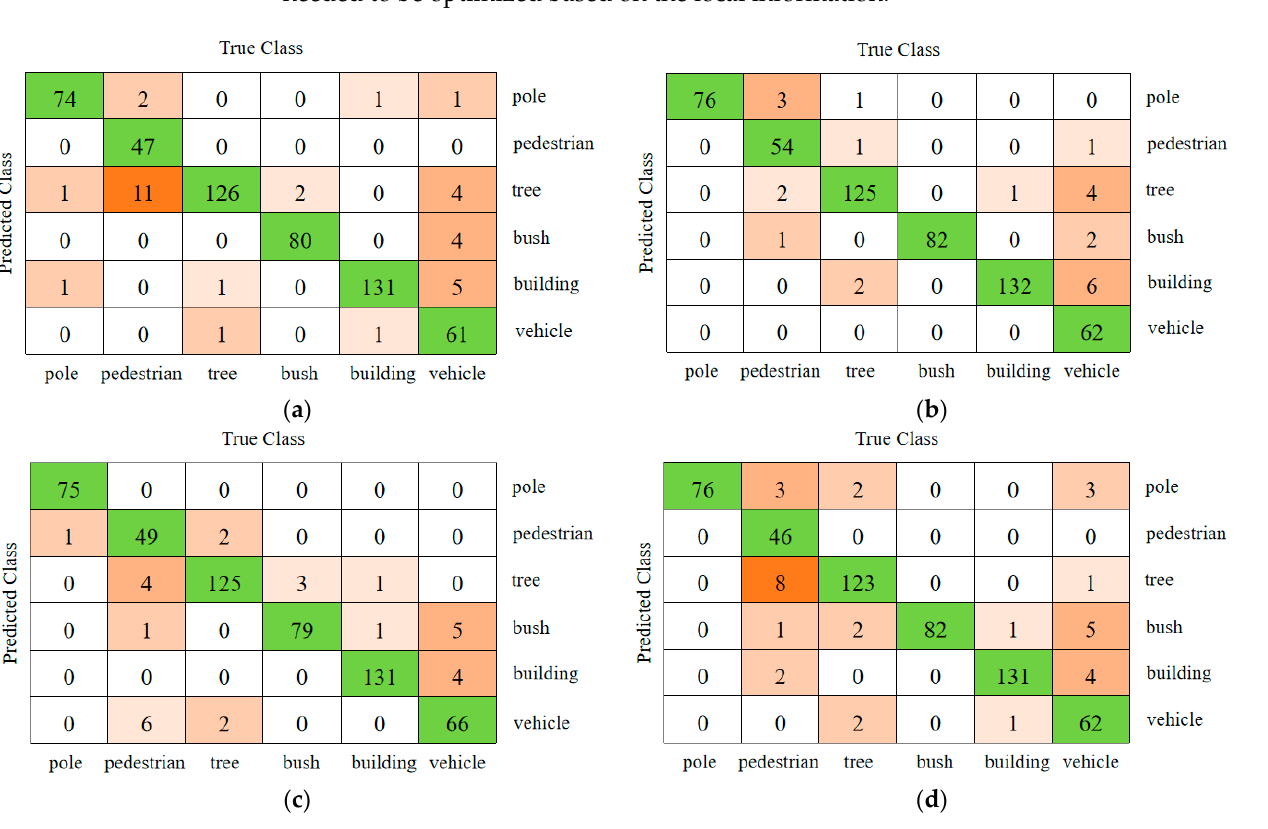
Figure 10. Classification confusion matrix for 6 kinds of object point clouds with different resolu ‐ tions: ( a ) 20 × 20 × 20, ( b ) 25 × 25 × 25, ( c ) 30 × 30 × 30, ( d ) 32 × 32 × 32. ( a ) 20 × 20 × 20, ( b ) 25 × 25 × 25, ( c ) 30 × 30 × 30, ( d ) 32 × 32 ×